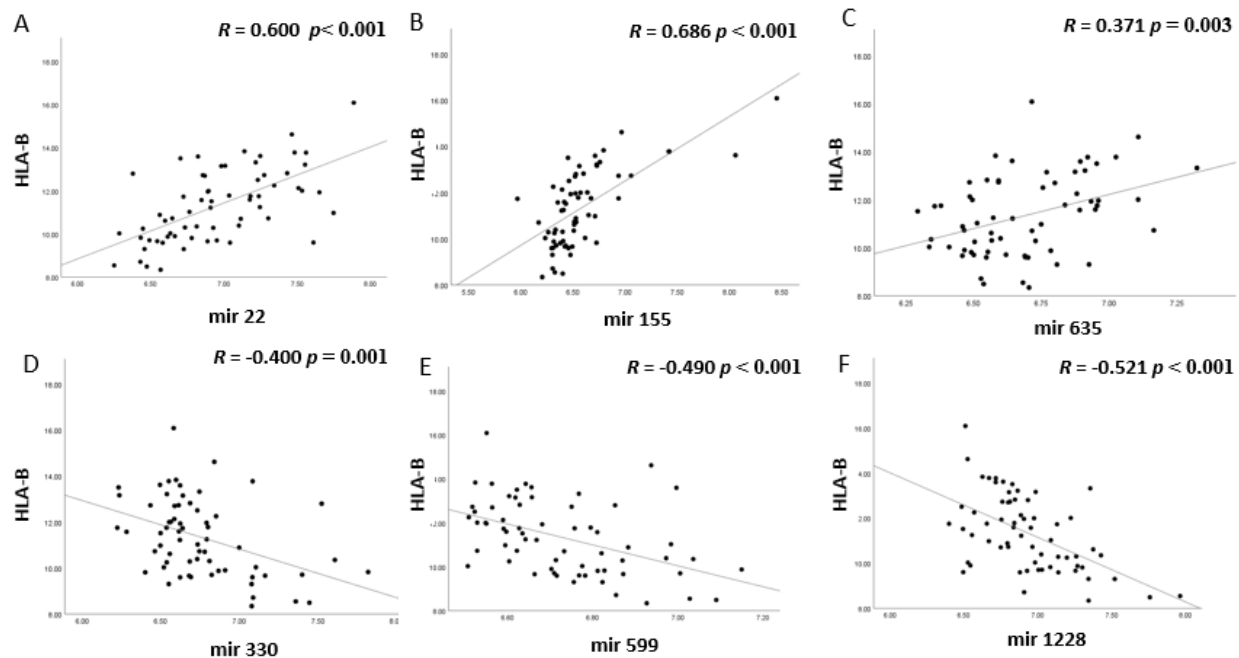
Figure 4. The expression levels of six different miRNAs ( A – F ) were compared to HLA-B mRNA levels in 64 Uveal FIg5: Melanoma from Leiden. Positive and negative patterns are observed. p values were determined by Spearman correlation. p ≤ 0.05 was considered significant. ( A ) miR-22, ( B ) miR-155, ( C ) miR-635, ( D ) miR-330; ( E ) miR-599; ( F ) miR-1228 versus HLA-B expression.